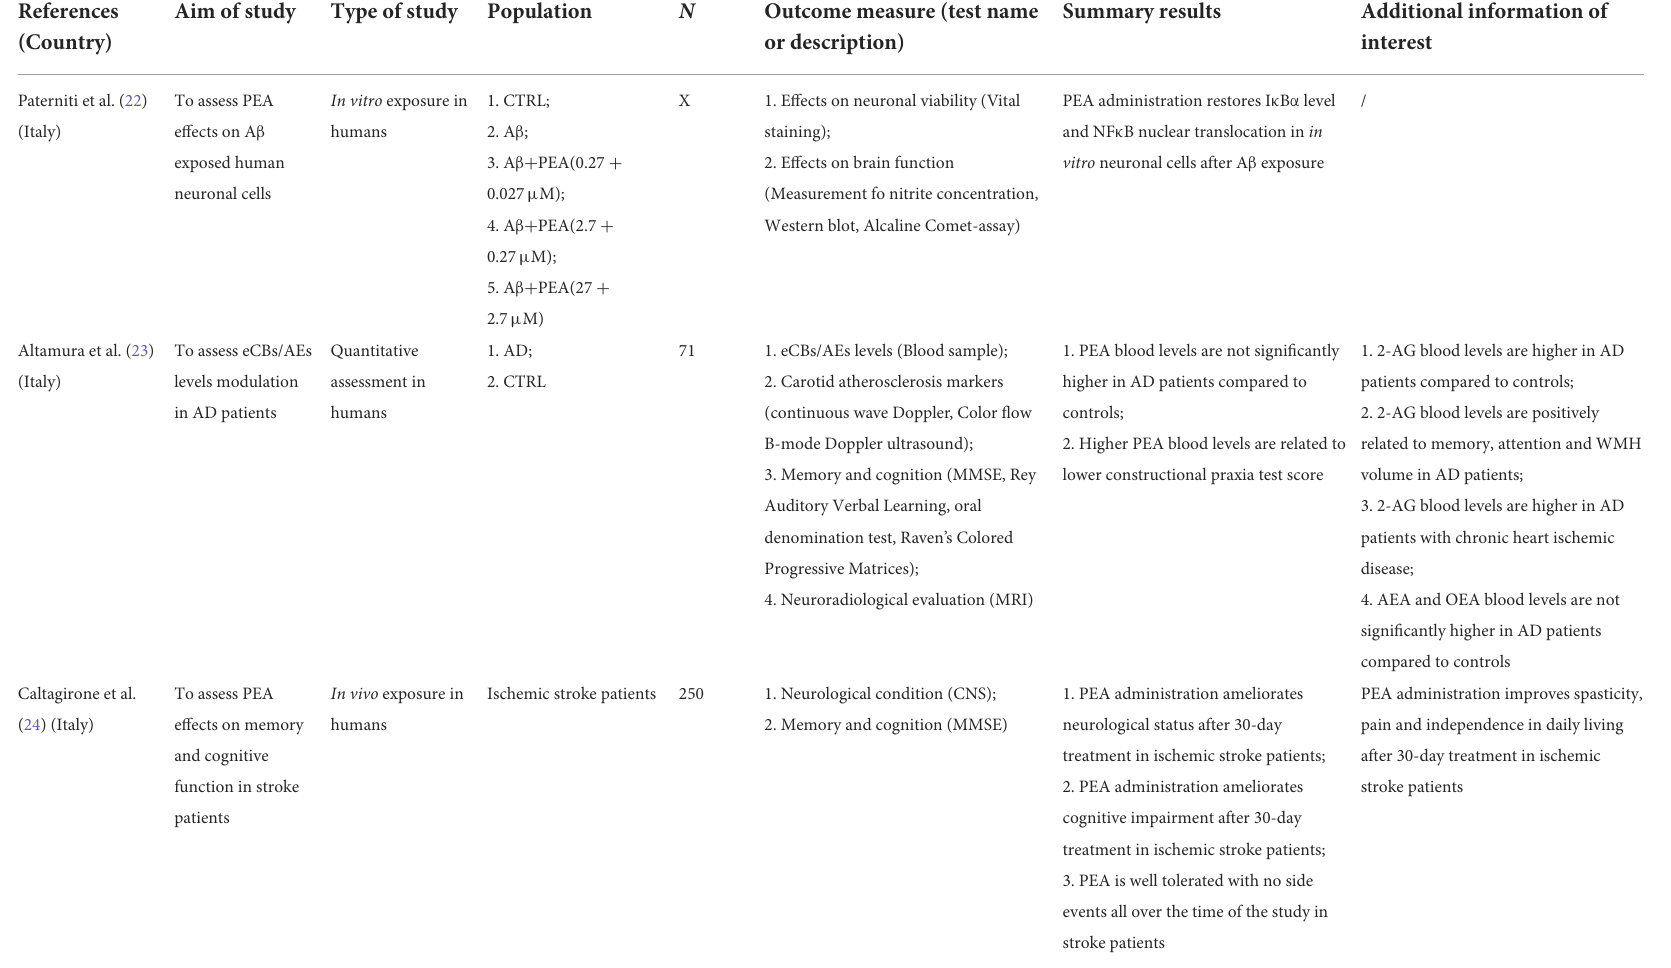
TABLE 1A Summary of clinical studies investigating palmitoylethanolamide and its correlations to neurocognitive disorders